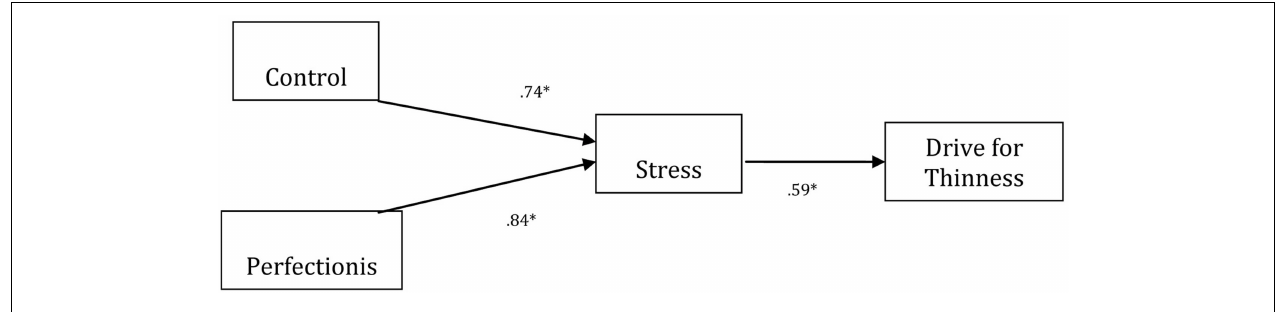
omitted. * p < 0 . 05 . Fitting index data: ( χ 2 = 16 , 769 . 25 ; gdl = 387 ; p < 0 . 001 ; CFI = 0 . 960 ; NNFI = 0 . 956 ; GFI = 0 . 967 ; AGFI = 0 . 968 ; RMSEA = 0 . 034